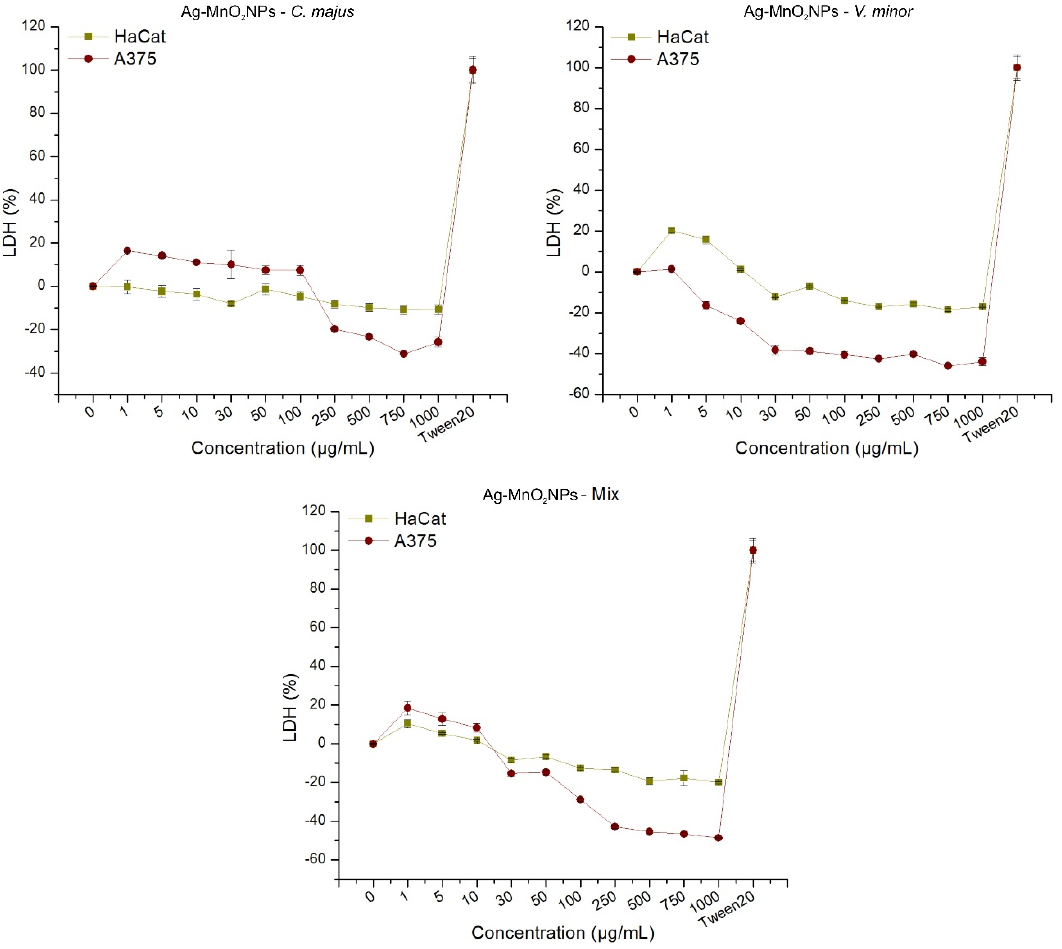
Figure 7. In vitro analysis of LDH release on normal keratinocytes (HaCaT) and skin melanoma (A375) treated with green synthesized Ag-MnO 2 NPs using the three plant extract